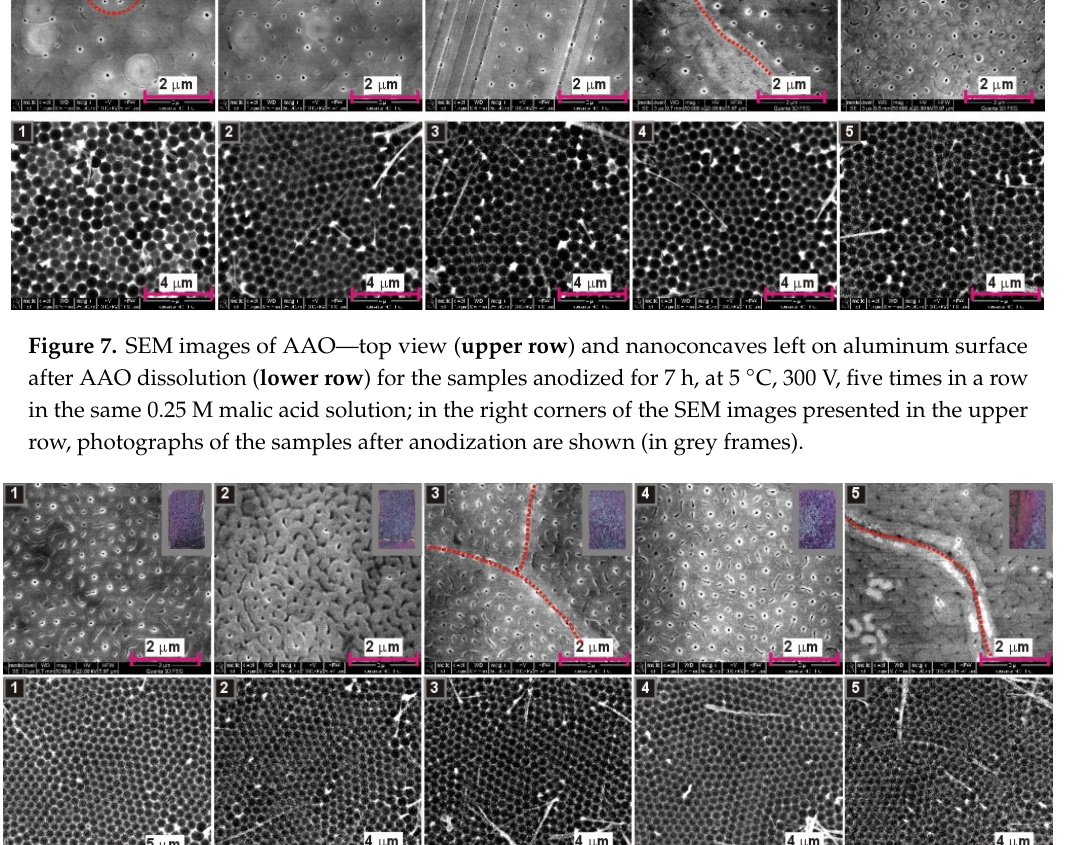
Figure 8. SEM images of AAO—top view (upper row) and nanoconcaves left on aluminum surface after AAO dissolution (lower row) for the samples anodized for 6 h, at 5 °C, 250 V, five times in a row in the same 0.5 M malic acid solution; in the right corners of the SEM images presented in the upper row, photographs of the samples after anodization are shown (in grey frames).